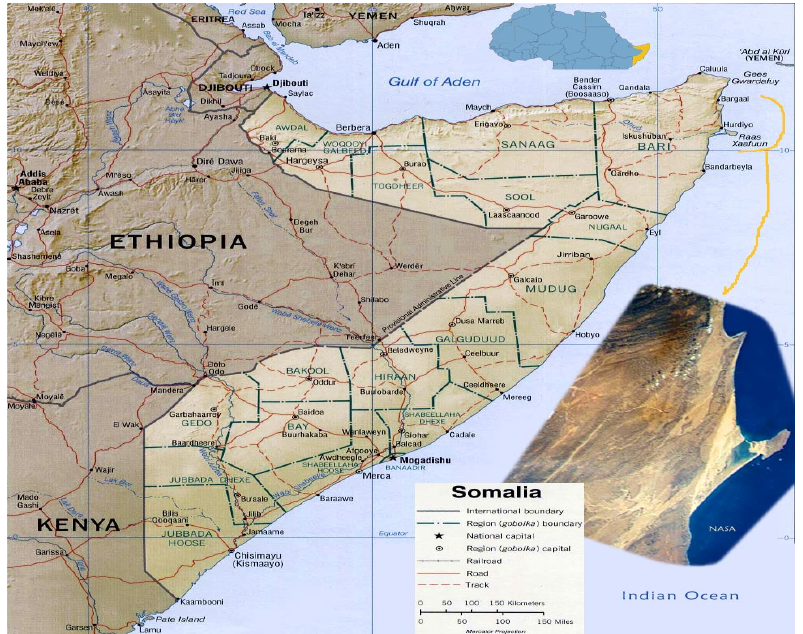
Figure 1. Map of Somalia 1 . Source: (Geographic Guide Somalia n.d.): http://www.geographicguide.net/africa/images/somalia ‐ map.jpg (accessed on 11 September 2022).